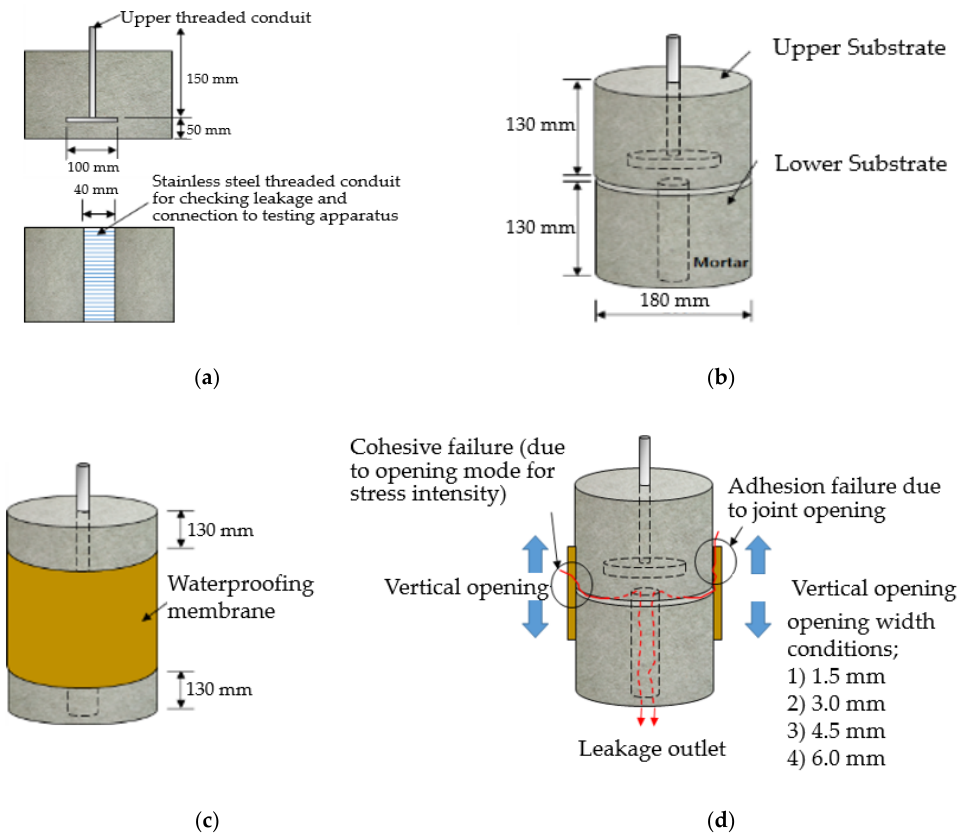
Figure 9. Crack opening testing specimen (mortar substrate) structure layout; ( a ) mortar substrate inner structure schematic, ( b ) mortar substrate dimensions and labels, ( c ) waterproofing membrane installed (henceforth called specimen), ( d ) opening resistance testing illustrated.